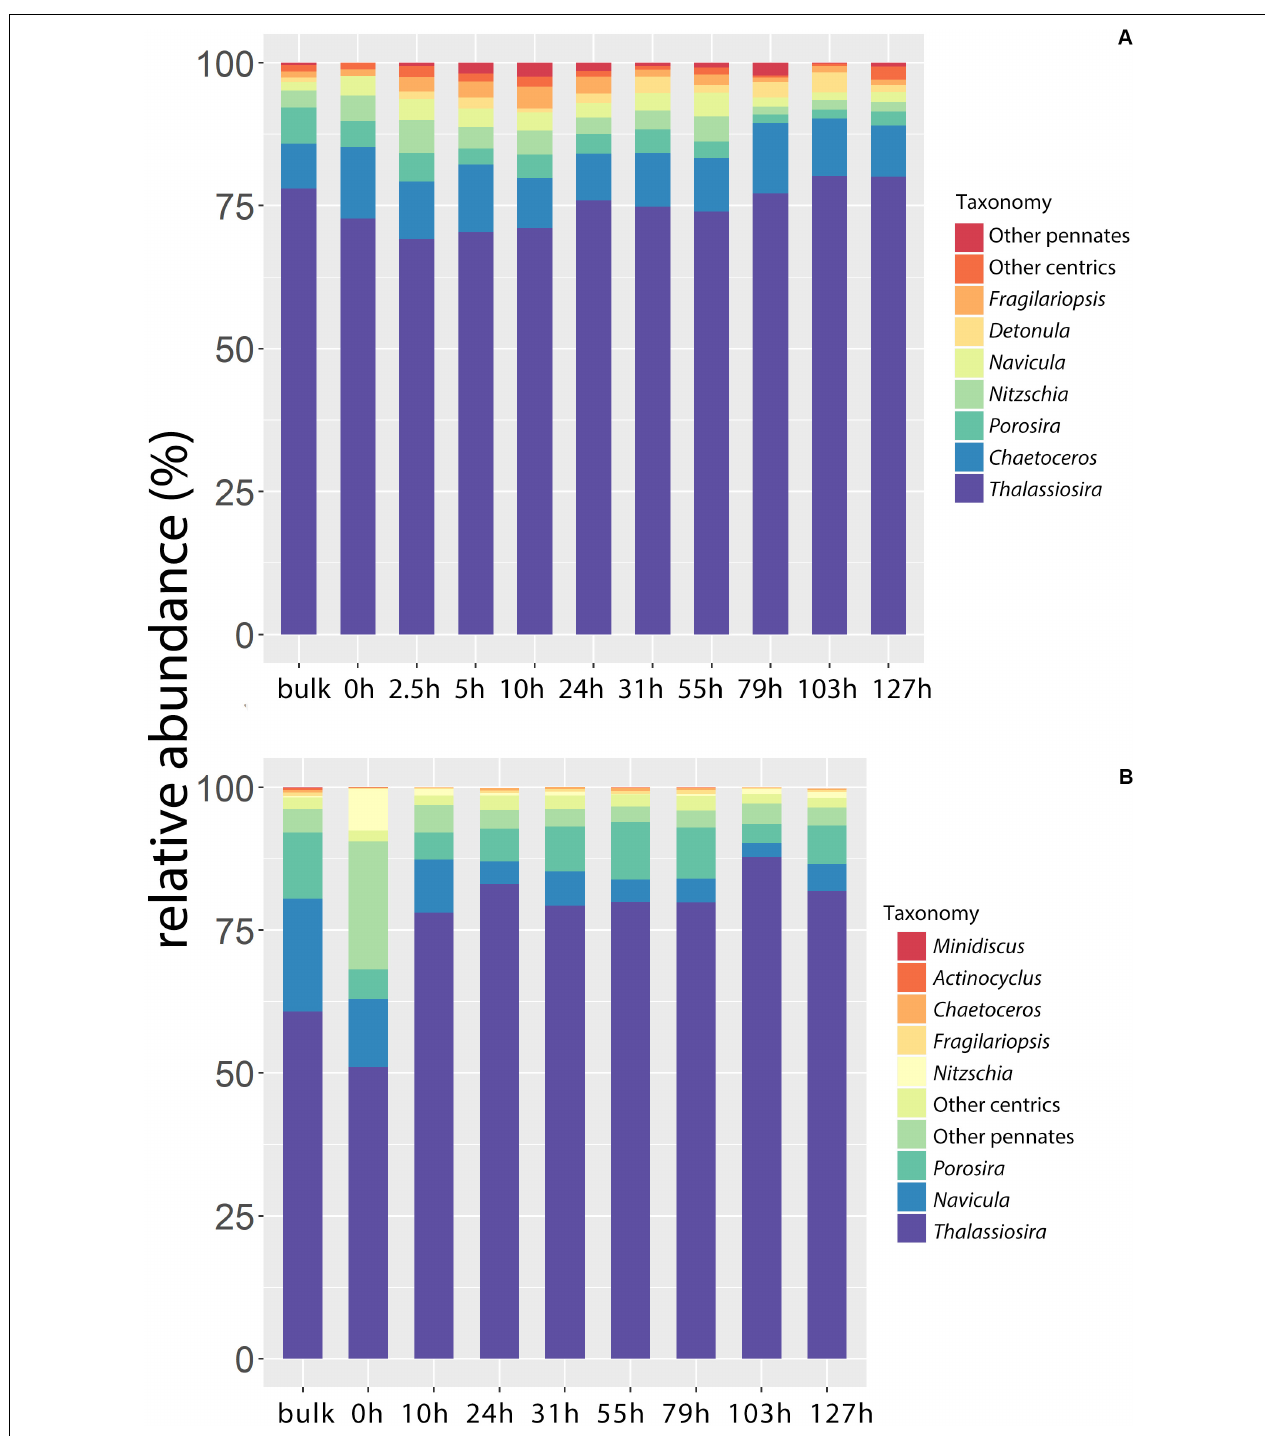
FIGURE 3 | The relative abundance of diatom genus or groups (%) in the bulk ice and during the incubation. (A) Light microscopy (LM); (B) 18S rDNA metabarcoding. The diatom genus or groups shown in the figure need to meet the following two standards: (1) The top 10 abundant ones (i.e., abundance of cells or gene fragments) during the whole incubation. (2) Genus or groups that were found at each time of sampling. Other genus or groups were added up to groups of other pennates and other centrics.